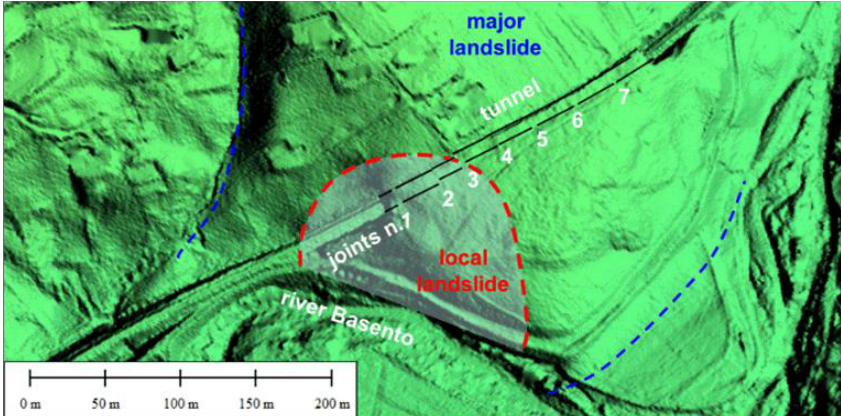
In Figure 7, START indicates the launching section for the pump wave, while END indi-